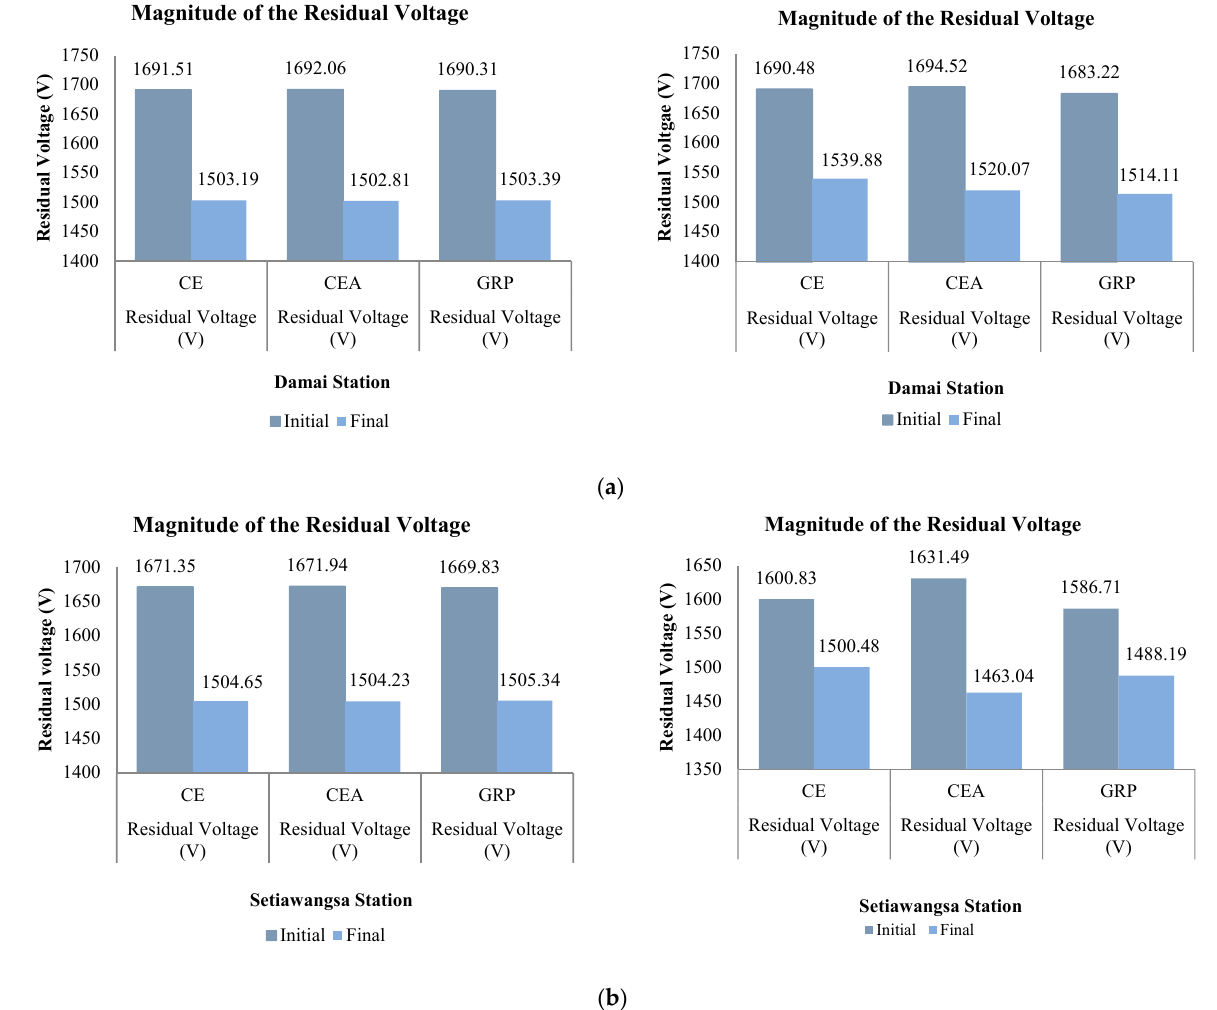
Figure 11. Residual voltage magnitudes of the ( a ) Setiawangsa Station and ( b ) Damai Station surge arresters for both 30 kA ( left ) and 90 kA ( right ).